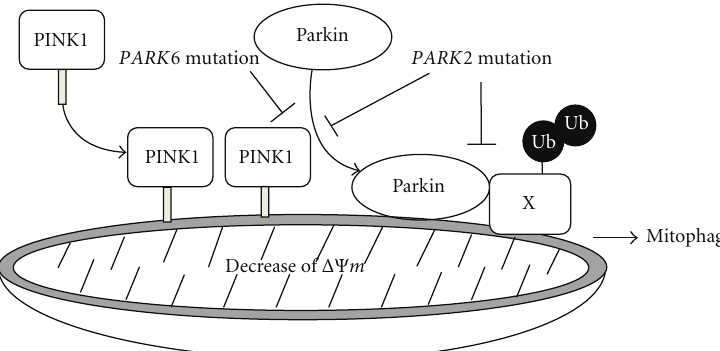
Figure 1: Schematic representation of PINK1-parkin-mediated mitophagy. In damaged mitochondria, PINK1 and parkin regulate mitochondrial elimination by inducing mitophagy. Under steady state, PINK1 is cleaved and degraded rapidly in the mitochondria. This process may be inhibited by the mitochondrial depolarization, resulting in PINK1 accumulation in the mitochondria. This accumulation is a crucial signal for parkin recruitment to the mitochondria. Parkin is presumed to ubiquitinate substrate (X), resulting in the induction of